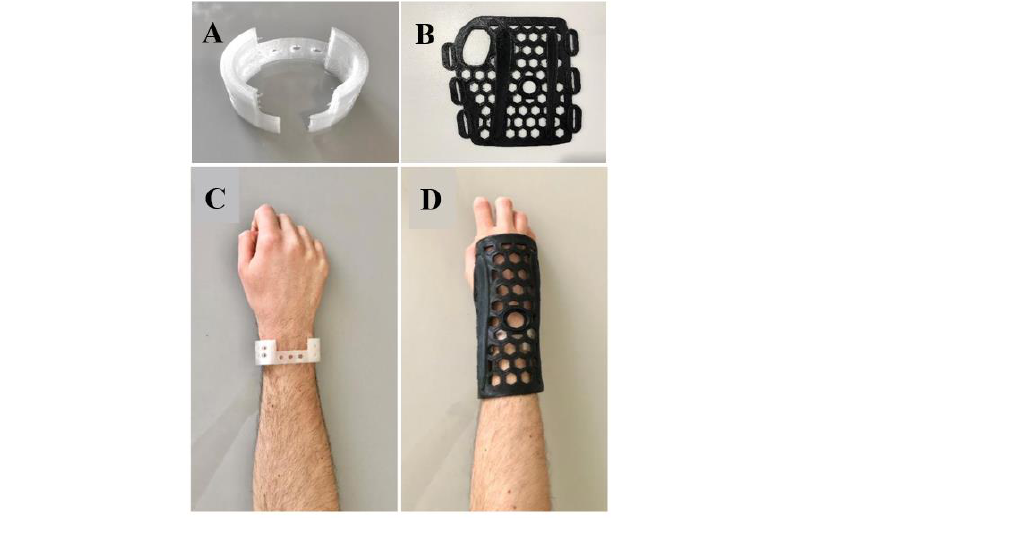
Figure 2. Modeling of the meshes printed on the wrist of a person to illustrate the way of use, where ( A ) it is the inner fixation mesh printed; ( B ) the outer immobilization mesh printed; ( C ) only the placement of the inner fixation mesh and ( D ) the joint use of the fixation mesh with the immobilization mesh. Table 1. Records of magnetic field values for stimulation in the coil by alternating and continuous electrical signal with readings of signal capture distances. Scenario